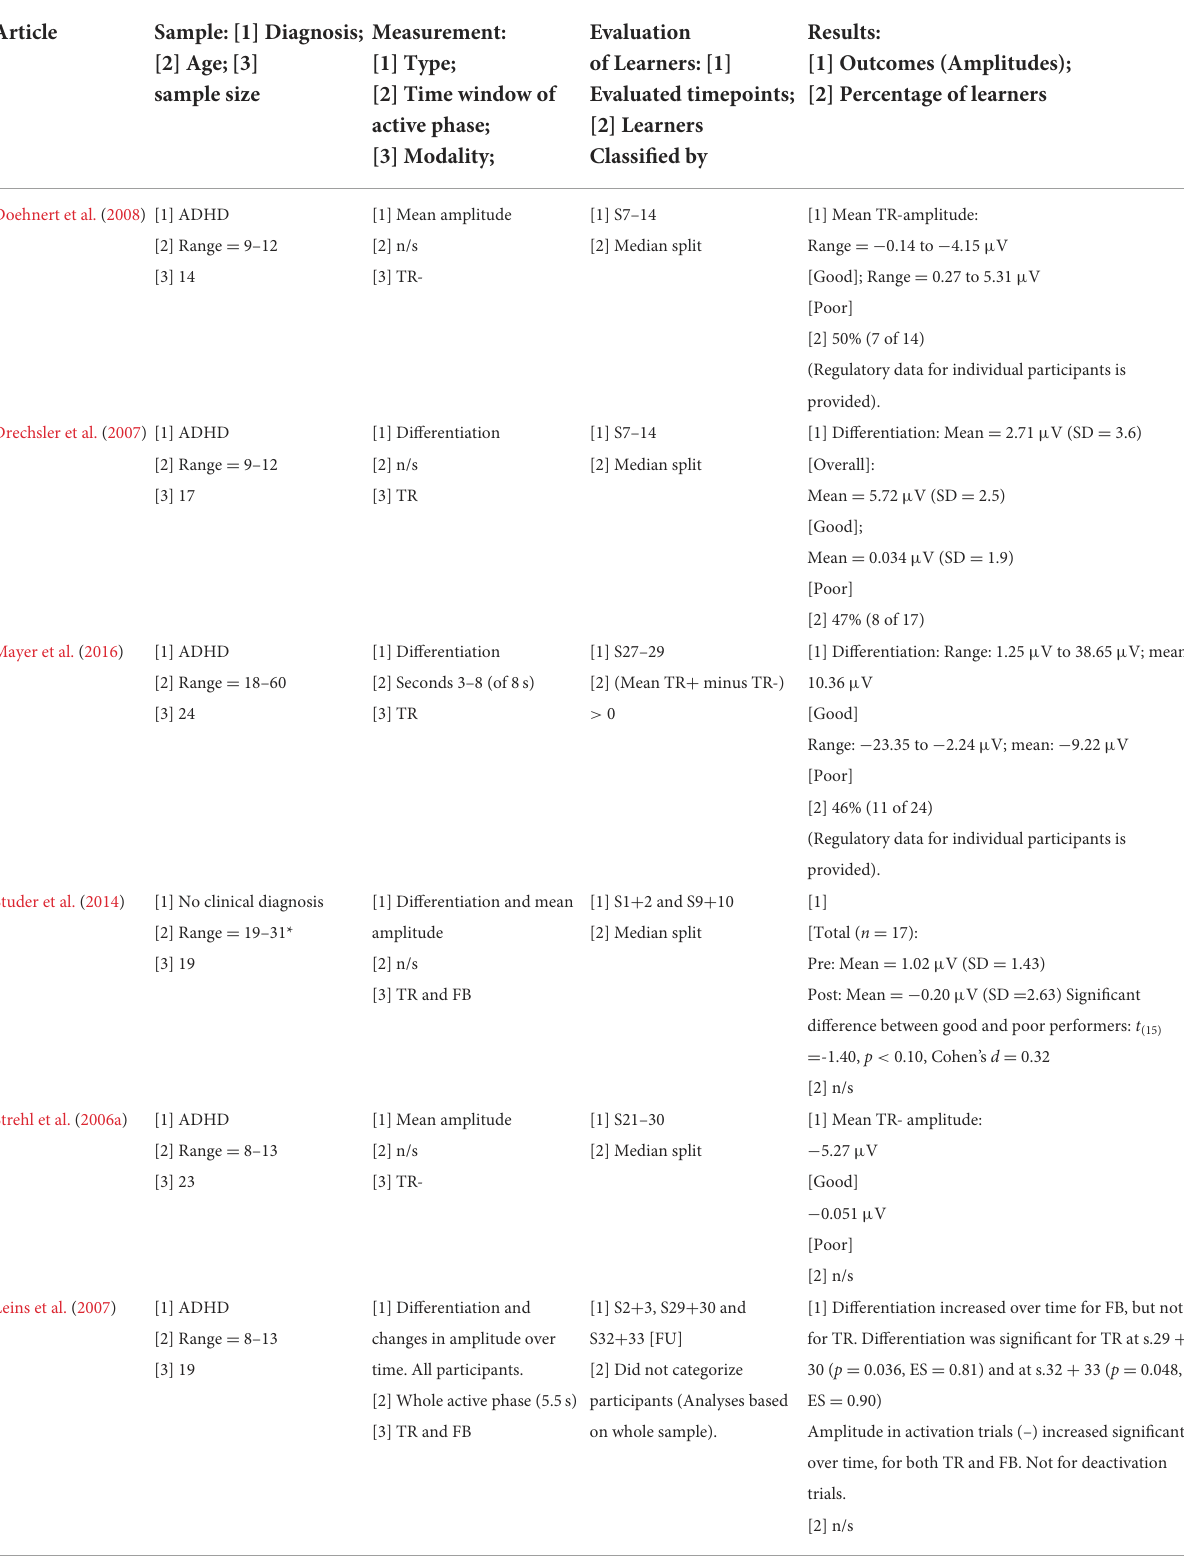
TABLE 2 Overview of articles that evaluated